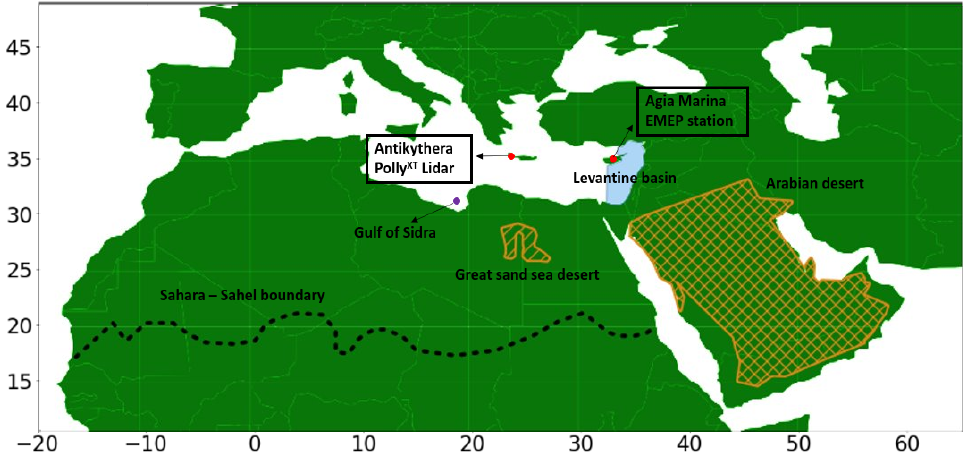
Figure A1. Model domain used in the WRF-Chem simulations alongside some locations and observation stations mentioned in the text.